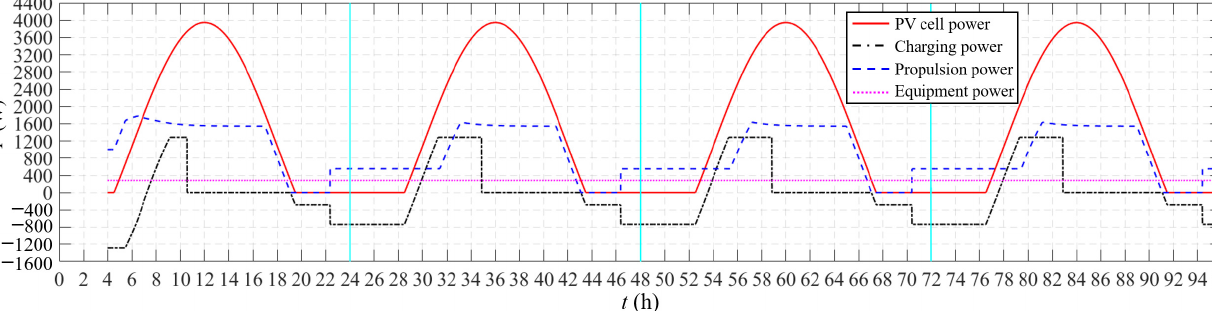
Figure 21. Power spectrum of typical flight profile.